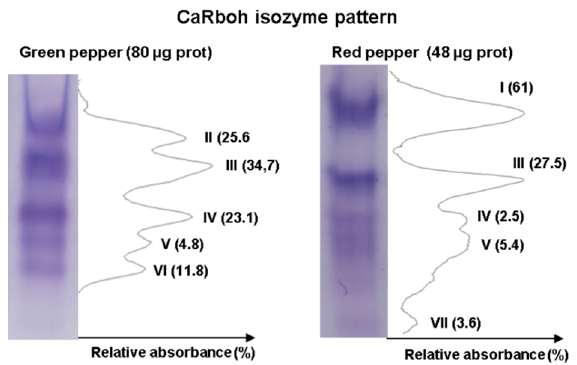
Figure 3. Activity of CaRboh isozymes in green and red pepper fruits. Protein samples were separated by non-denaturing polyacrylamide gel electrophoresis (PAGE, 6%) and activity was detected by the nitro blue tetrazolium (NBT) reducing method. For green and red peppers, 80 µg and 48 µg of protein were loaded per lane, respectively. Band intensity was quantified using ImageJ 1.45 software. Table 1. Identification (I to VII) and relative abundance (%) of the respiratory burst oxidase homolog (CaRboh) isozymes detected in green and red pepper ( Capsicum annuum L.) fruits by the NBT reducing method after non-denaturing PAGE. Band intensity was quantified using ImageJ 1.45 software.